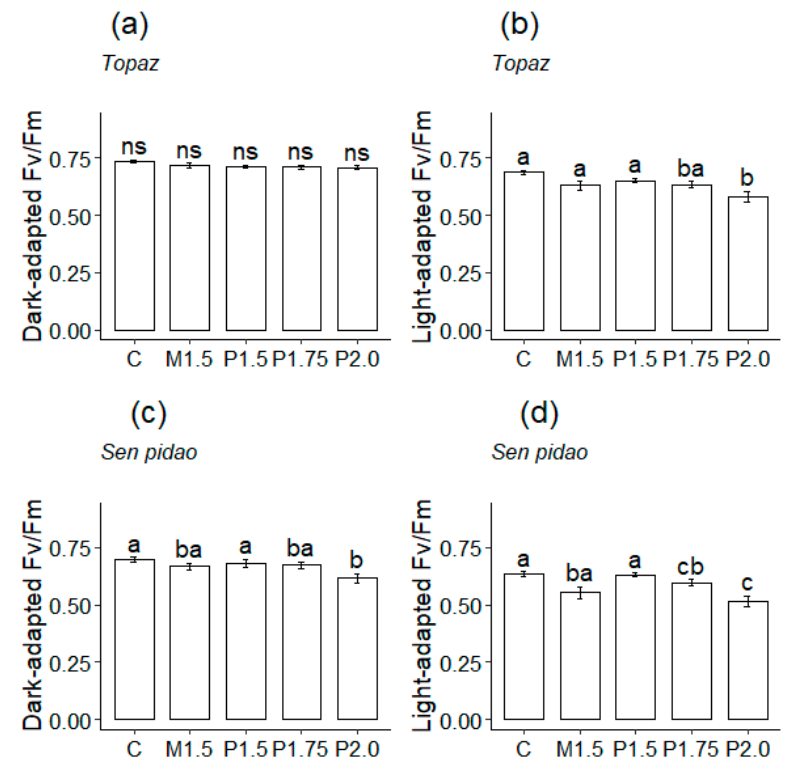
Figure 5. Dark-adapted (Fv/Fm) and light-adapted (F’v/F’m) of Topaz ( a , b ) and Sen pidao ( c , d ) varieties, respectively, under different herbicide treatments; P1.5, P1.75, P2.0 as pendimethalin rates at 1.5, 1.75, 2.0 kg a.i. ha − 1 , respectively, C represents the untreated control and M 1.5 is control 2 with 1.5 kg a.i. ha − 1 S -metolachlor herbicide. ‘ns’ represents not significant, while means of the same letters are not significantly different at p < 0.05; error bars represent the standard error.